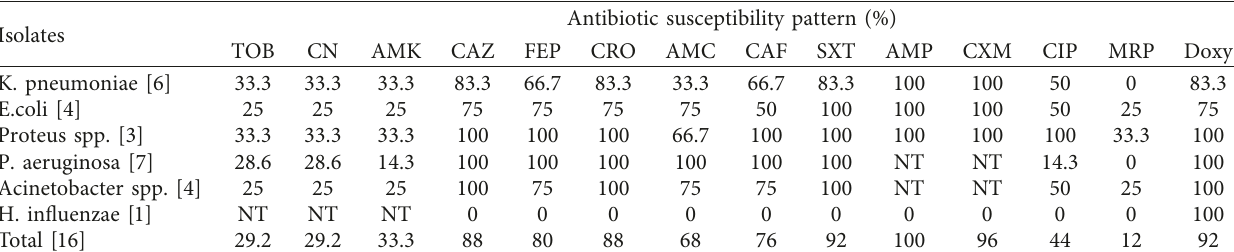
Table 4: Antibiotic susceptibility pattern of Gram-negative bacterial pathogens to tested antibiotics in patients with AECOPD at JUMC, southwest Ethiopia, 2019.